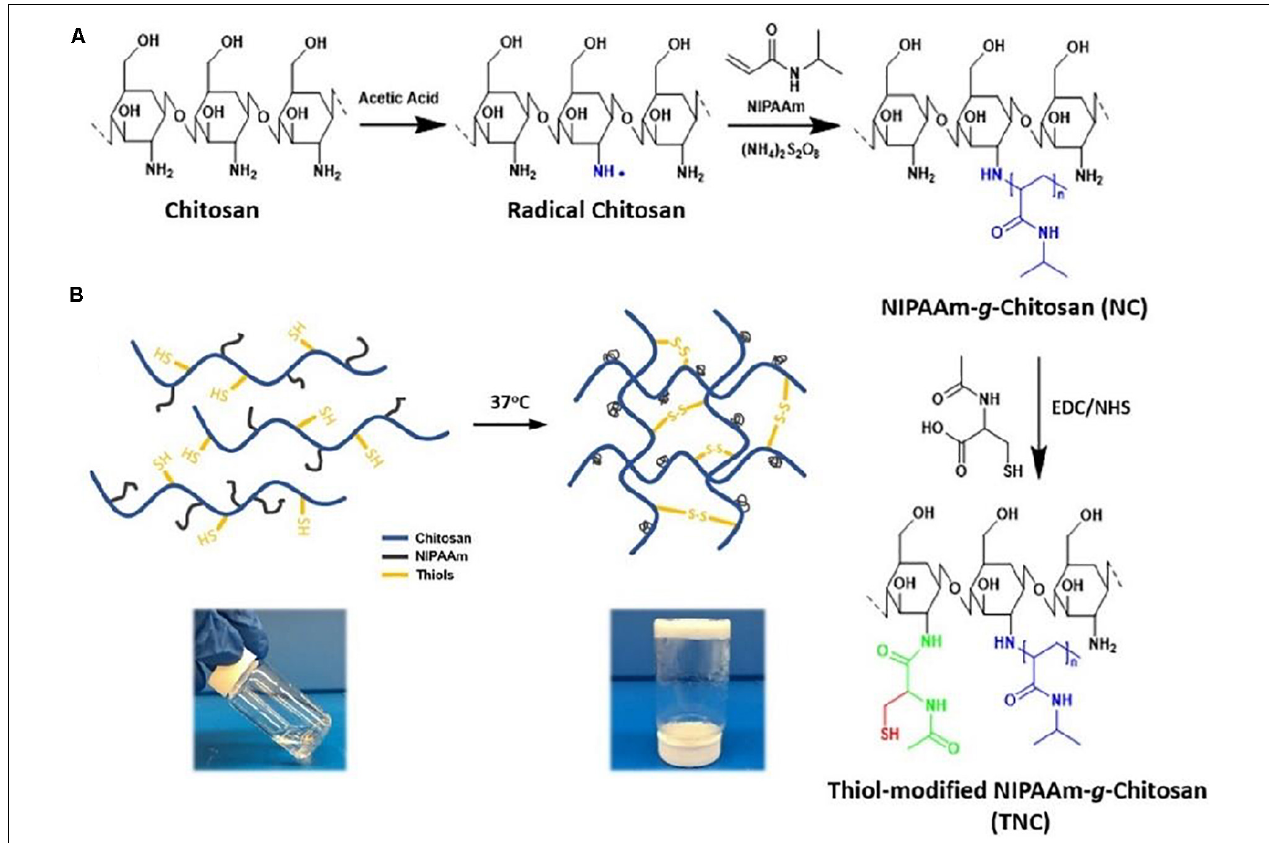
FIGURE 5 | (A) Synthetic preparation of NIPAAm-g-CS. (B) Gelation mechanism of physical cross-linking (helix-coil structure) and chemical cross-linking (disulfide bonds). Reproduced from Wu et al. (2018) with permission from Copyright 2018